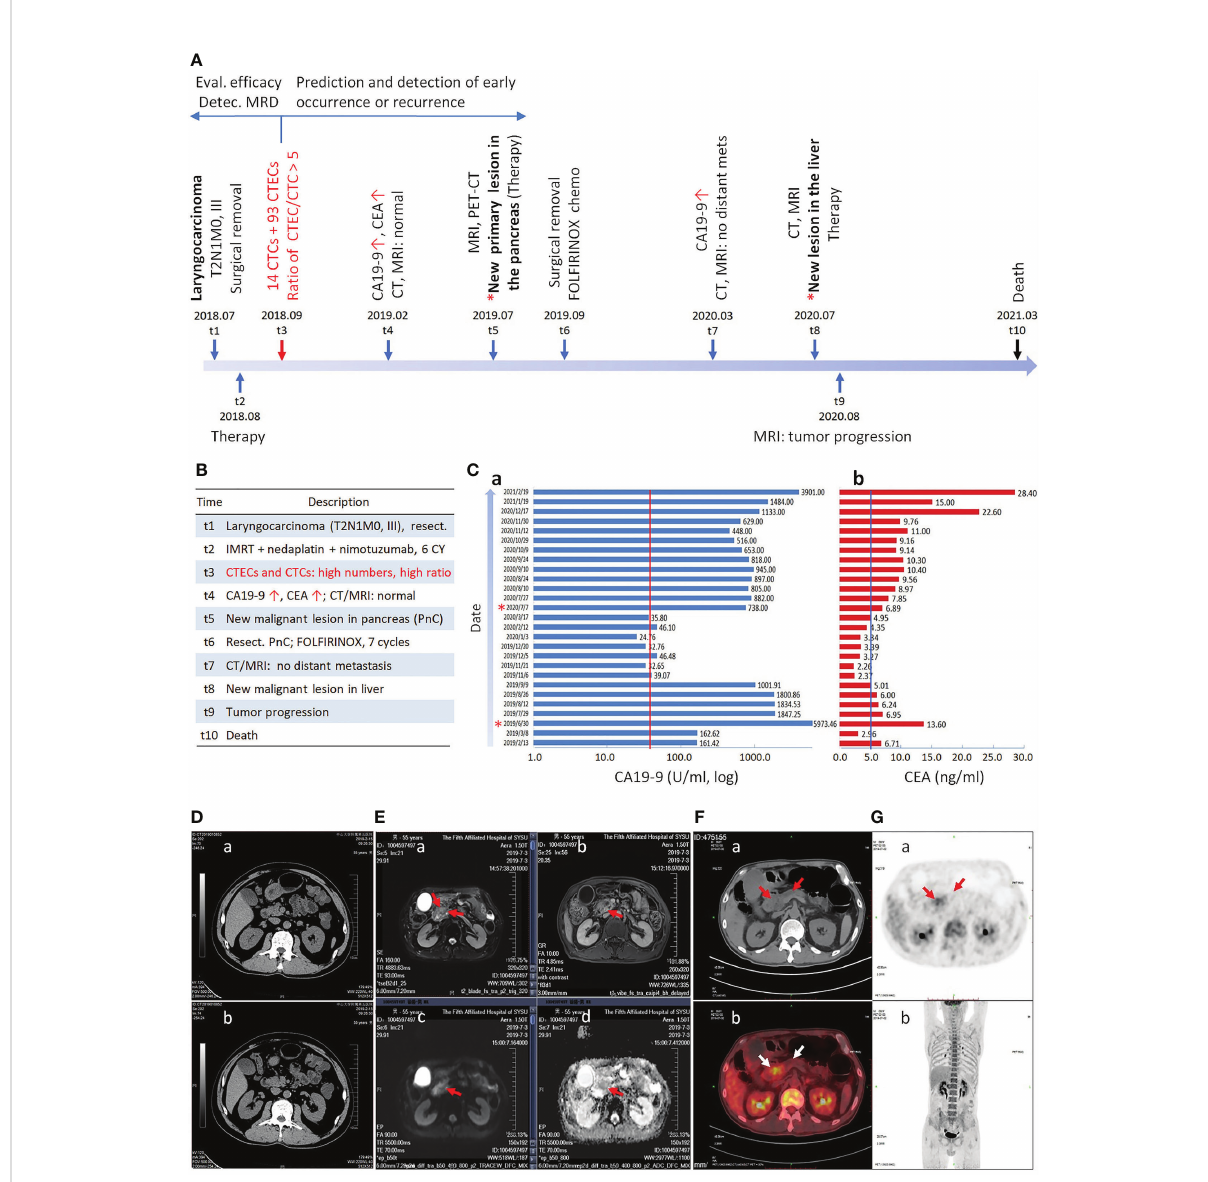
FIGURE 1 Longitudinal progression of the cancer patient. (A) Timeline of diagnosis and treatment of the patient at different time intervals is illustrated. The primary laryngocarcinoma is diagnosed at t1, followed by detection of CTCs and CTECs at t3. A new malignant lesion in the pancreas is con fi rmed at t5. Detection of CTCs and CTECs at the end of therapy could effectively evaluate therapeutic ef fi cacy, detect MRD, and predict early occurrence of malignancy. (B) Description of each time point from t1 to t10. (C) Continuous monitoring of CA19-9 and CEA. The patient has the highest concentration of CA19-9 at t5. The cut-off values of CA19-9 (37 U/ml) and CEA (5 ng/ml) are indicated by red and blue line, respectively. (D – G) Medical imaging. (Da, b) Abdominal CT scan shows no abnormality in pancreas. (Ea – d) Epigastric MRI, CE-MRI, MRCP and DWI indicate the metastatic pancreatic head carcinoma. (Ea) A space-occupying lesion in pancreas T2WI (red arrows). (Eb) An increase contrast signal in a space-occupying lesion in pancreas T1WI (red arrow). (Ec) A strong signal in a space-occupying lesion in pancreas T1WI by DWI (red arrow). (Ed) ADC imaging shows decrease signal in a space-occupying lesion in pancreas T1WI (red arrow). (F, G) A pancreatic space-occupying lesion with enhanced glycometabolism shown by PET-CT (red and white